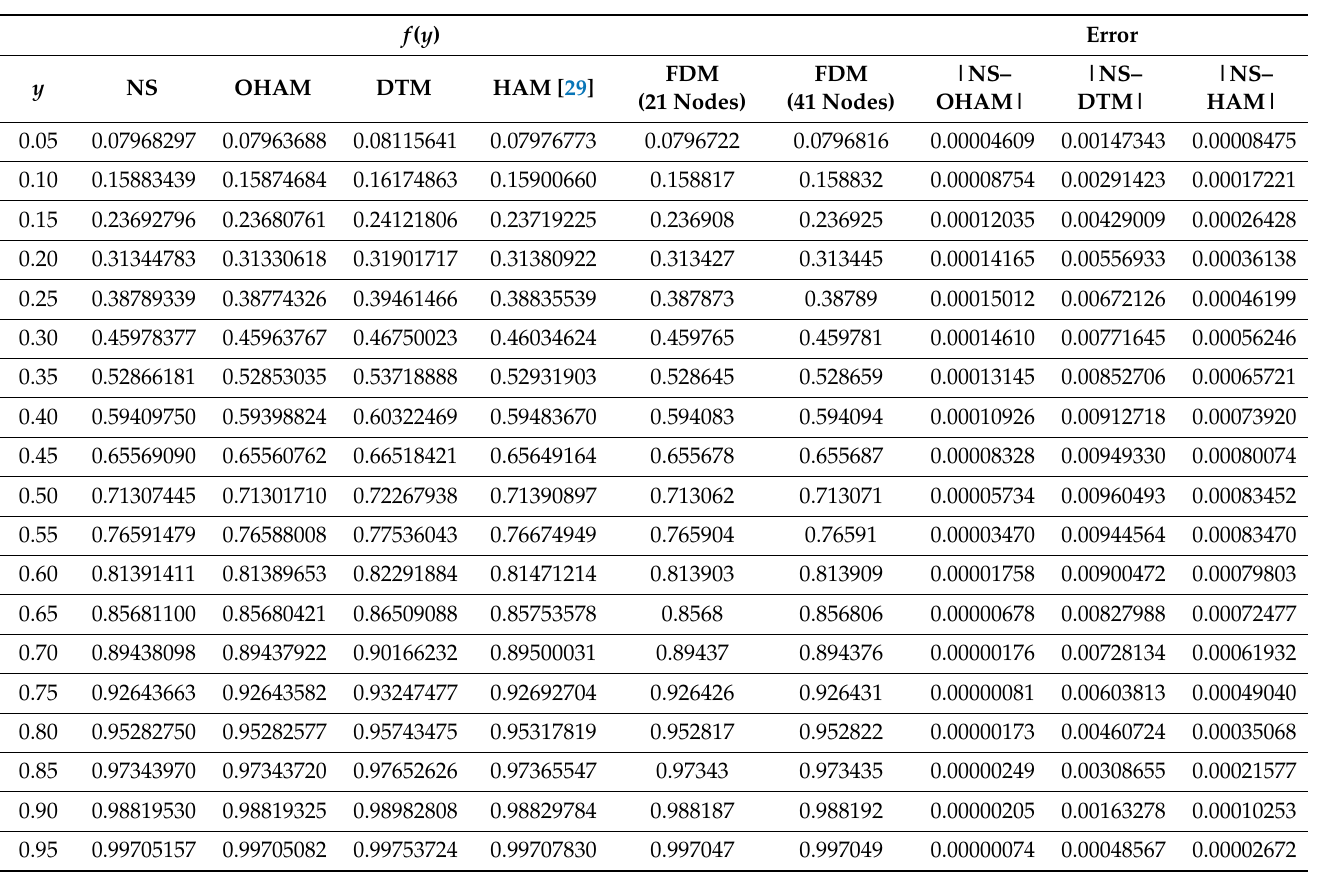
Table 1. Comparison of the numerical solution (NS) with the OHAM and HAM by 3rd-order approximate solution and DTM ( m = 10) for the case of Re = 5 and α =